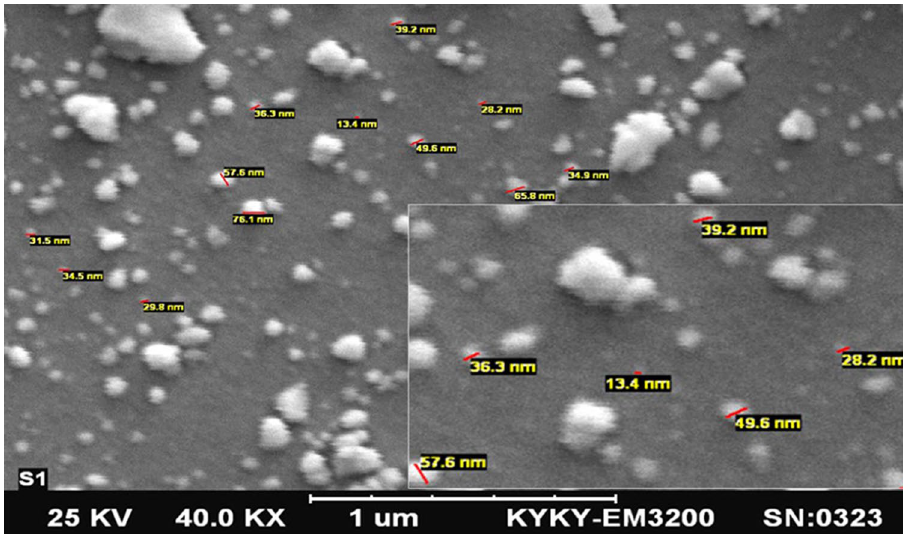
Fig. 3 Image obtained from SEM considering the size of the Fe +3 –TiO